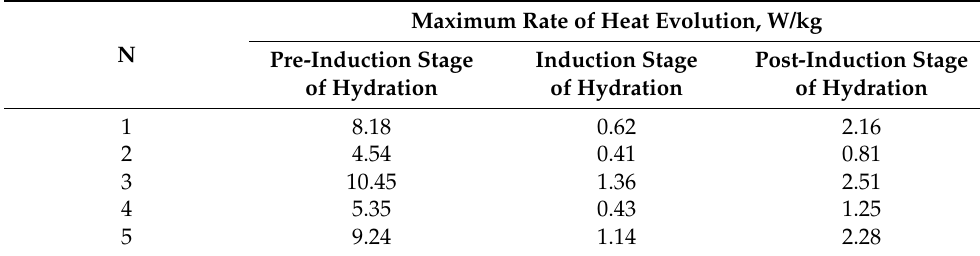
Table 5. Rates of heat release in all periods of hydration depending on the method of WG introduction.